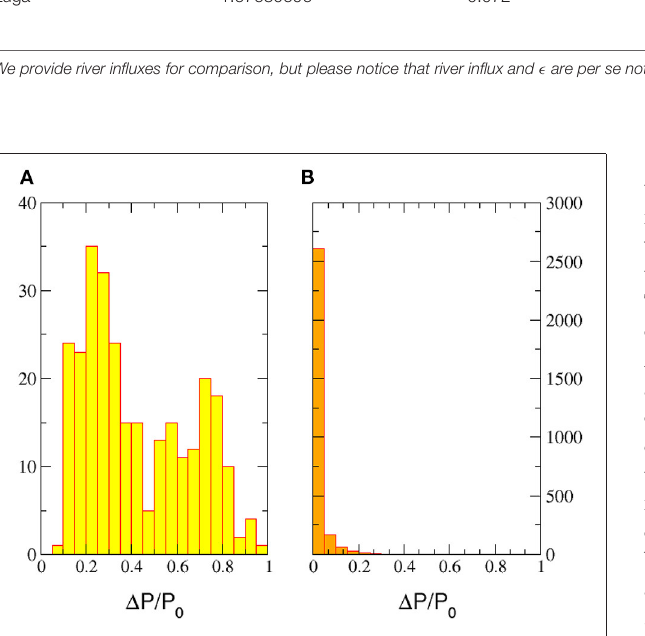
FIGURE 8 | Histogram of primary feasibility of cleanup by Equation (2) monitored at regularly spaced sampling points within Natura 2000 sites when (A) cleanup rivers Oder, Nemunas, Narva, Wisla, Luga, and Daugava in the Baltic Sea (monitored at 280 points), and (B) cleanup rivers Nile,